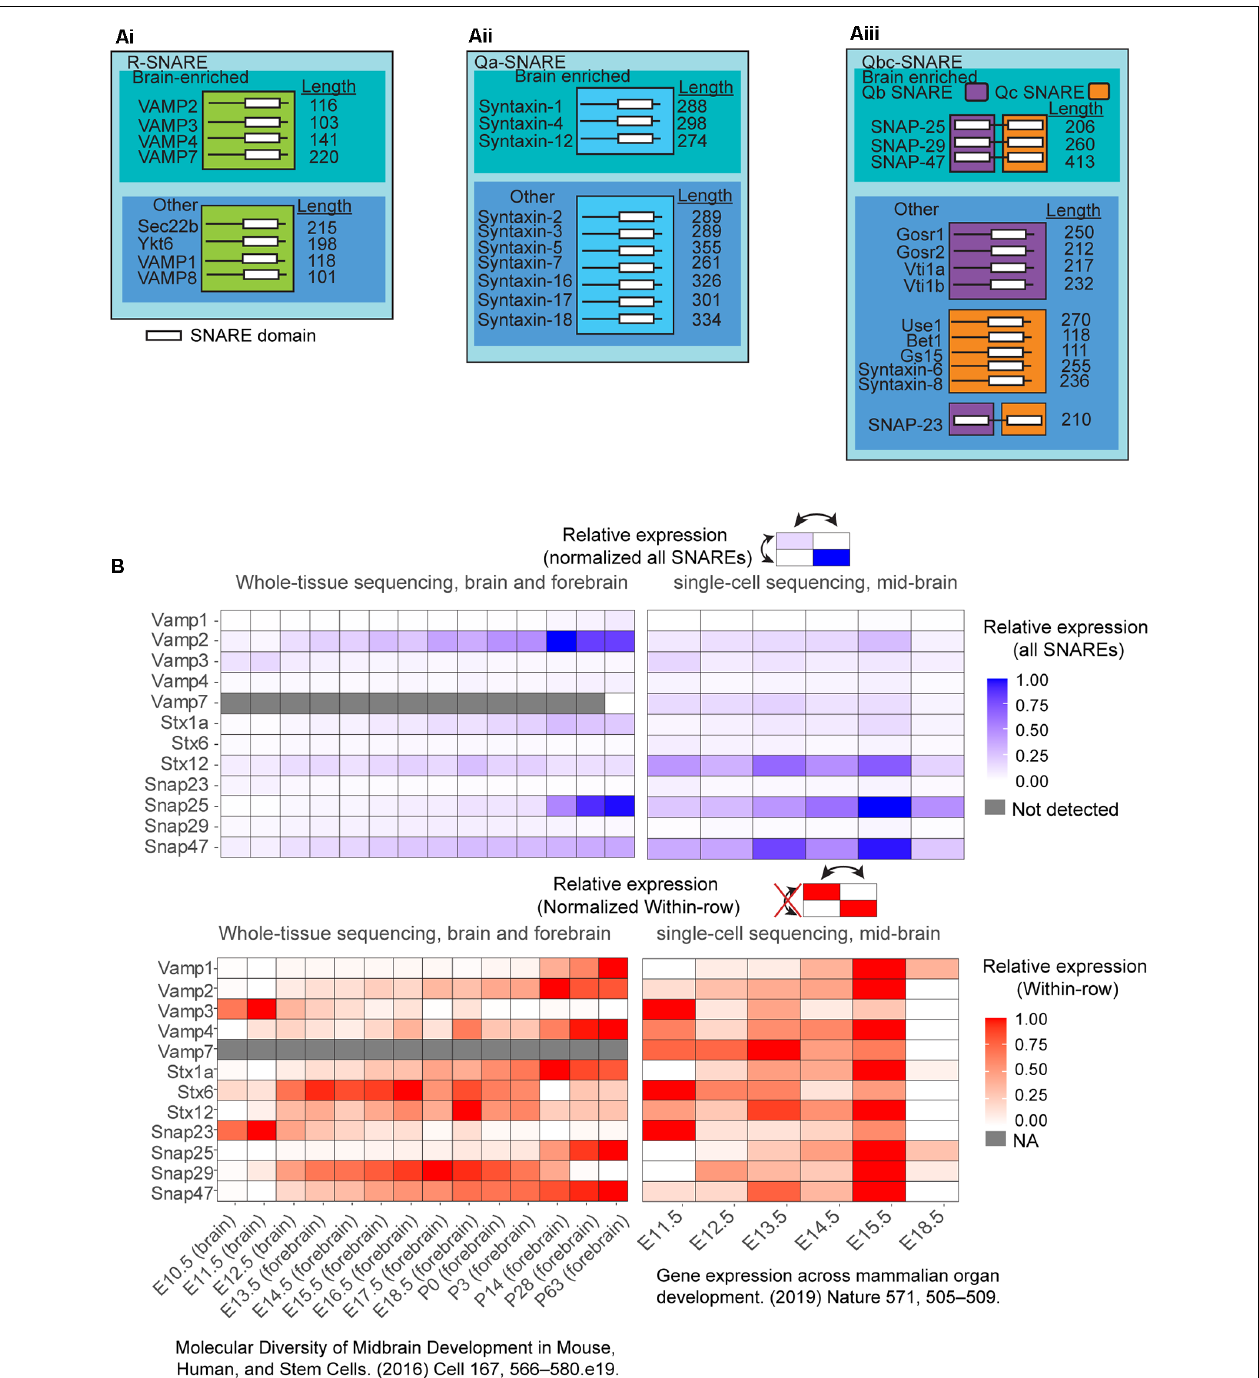
FIGURE 2 | (A) Selected list of the classified as Qabc-SNAREs and R-SNAREs and neuronally enriched SNARE expression in vivo in the murine brain. SNAREs are classified into: (Ai) R-SNAREs; (Aii) Qa-SNAREs; and (Aiii) Qbc-SNAREs. These SNAREs were further subset into brain-enriched or not brain-enriched. White bars in the illustration represent SNARE domains. (B) Expression from two different databases of select SNARE mRNA expression, one from whole-brain and forebrain sequencing, and another database from single-cell sequencing of the mid-brain over multiple developmental time points. SNARE expression was normalized to all SNAREs (blue) or normalized within-row (red) for identification of temporal peak expression for each individual. To compare across all SNAREs (blue), datasets of reads per kilobase of exon model per million mapped reads (RPKM) were filtered for SNARE expression. The expression data were normalized to the highest RPKM among all SNAREs was set to 1, and the lowest RPKM among all SNARES set to 0, and all SNAREs RPKMs were normalized between these two values. To compare SNARE expression within-row (red), the highest RPKM for each SNARE was set to 1, and the lowest RPKM was set to 0 separately for each SNARE.